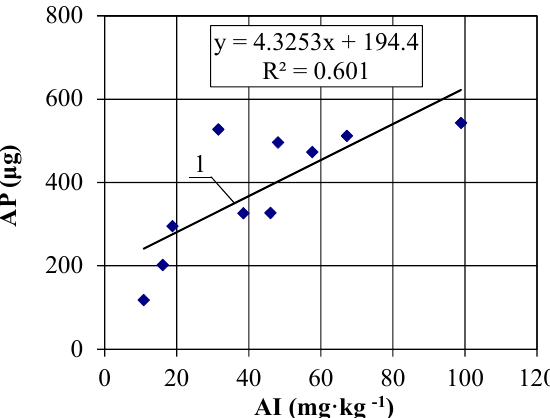
Figure 11. Scatter diagram of results showing the relationship between Abrasion Potential (AP) and Abrasion Index (AI), where 1 is regression line AP upon AI (R 2 = 0.601).